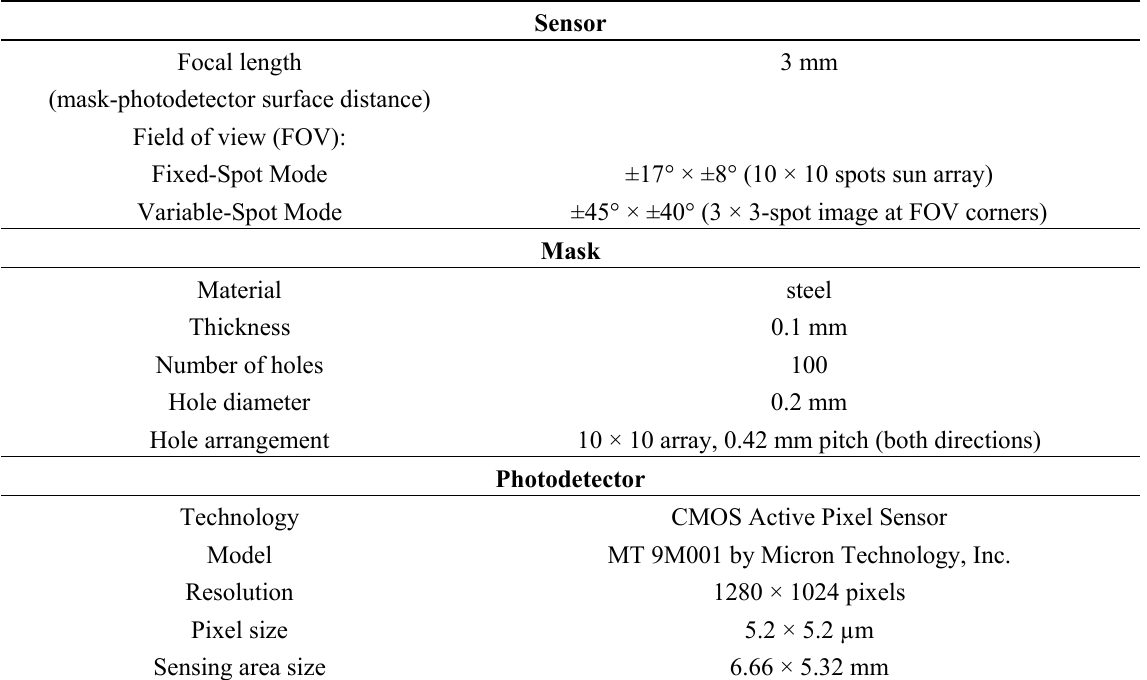
Table 1. Sensor Prototype Relevant Parameters.